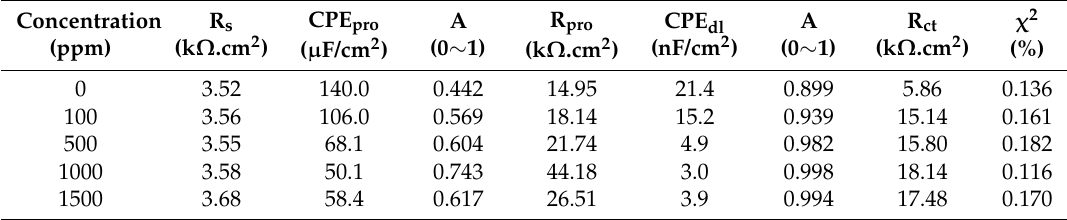
Table 3. Parameters obtained from the Nyquist plot fitting of steel after 24-hour immersing in simulated ethanol fuel blend solutions containing different APL-EAE concentrations following the equivalent circuit in Figure